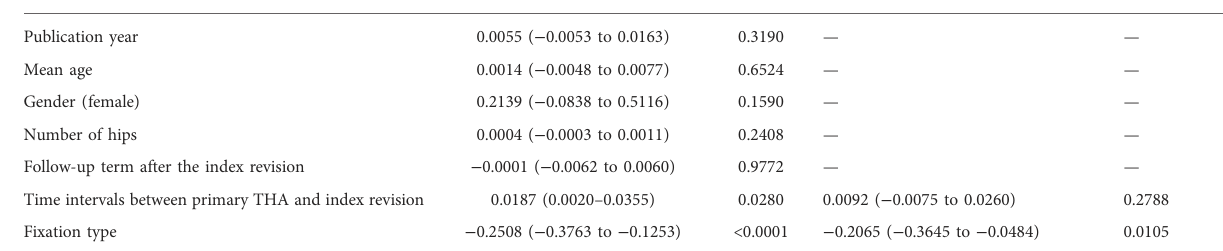
TABLE 3 Results of the meta-regression for re-revision rate for any reason. Parameters